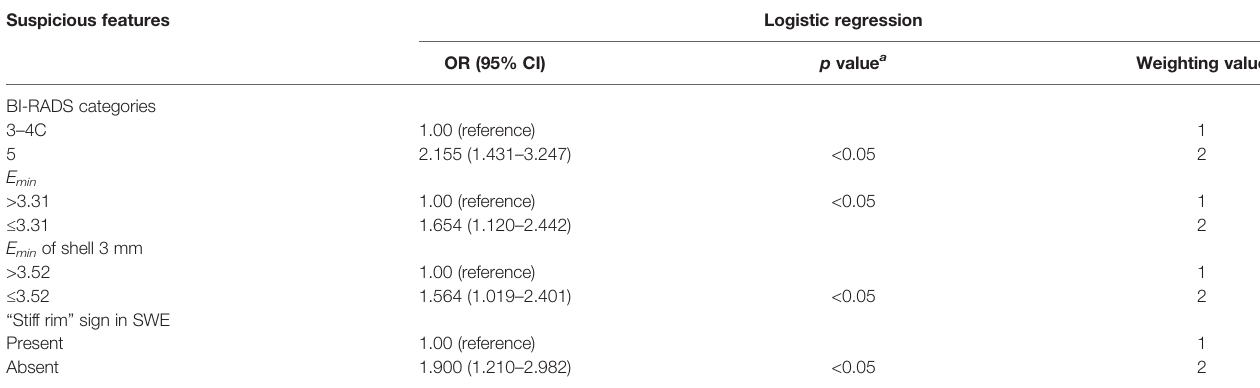
TABLE 5 | Odds ratios for the suspicious features between positive and negative LN groups and the corresponding weighting values. Suspicious features